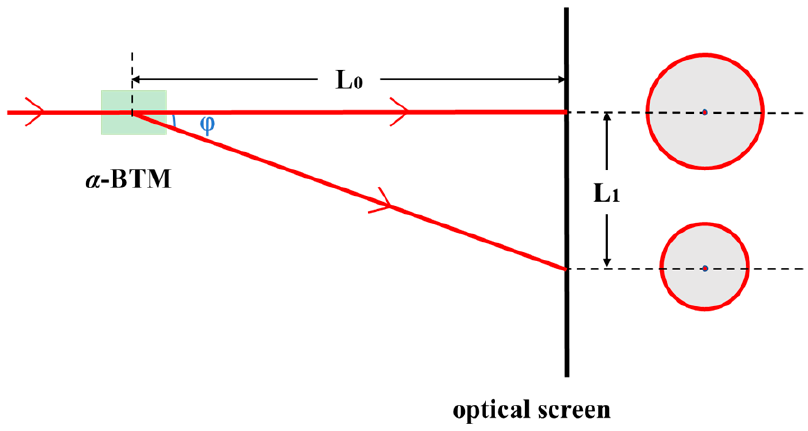
Figure 3. The schematic diagram for measuring the diffraction angle of the α -BTM AO switch at 639 nm.